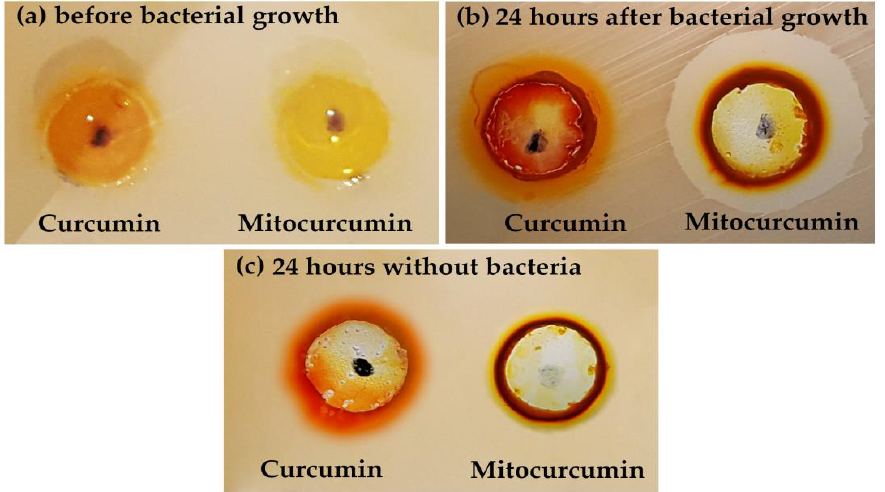
Figure 1. The well diffusion method showing the antibacterial effect of mitocurcumin against a standard MRSA strain (ATCC 700698) compared with curcumin at 10 µM ( a ) before and ( b ) after 24 h of incubation at 37 °C, and ( c ) control group with no bacteria inoculated on the agar plate. Table 1. Inhibition diameters of curcumin and mitocurcumin (both at 10 µ M) for MRSA. Inhibition Diameter Inhibition Diameter mm Strain mm (Curcumin) MRSA strain (ATCC